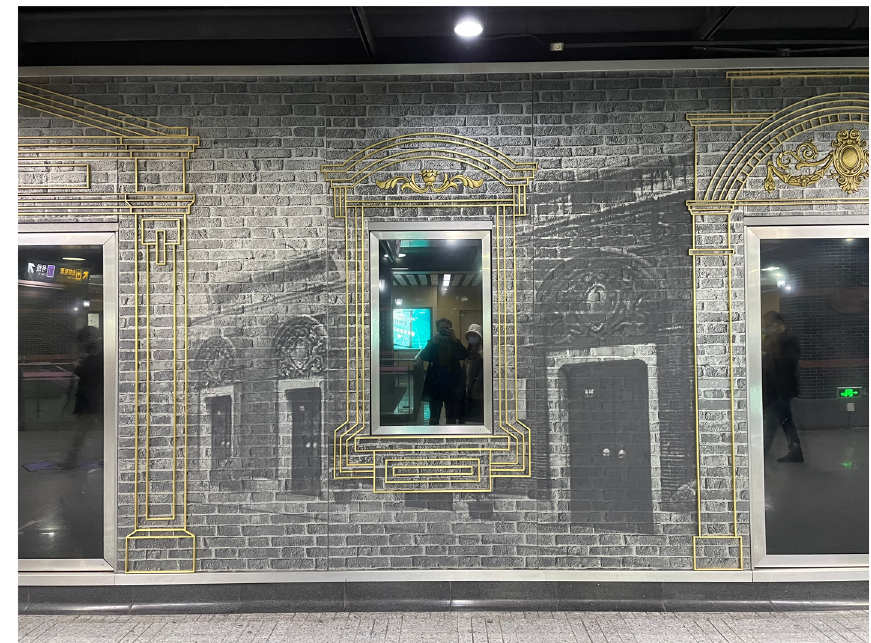
Fig. 12 Representation of the shikumen gate of 76 Xingye Road, Site of the First National Congress of the Communist Party of China. (Source: the